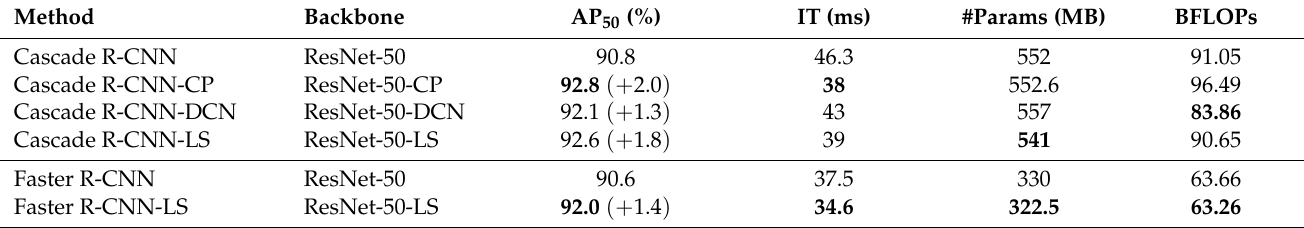
Table 1. Experiment results on SSDD with Cascade R-CNN and Faster R-CNN as baselines. The postfixes of “CP”, “DCN”, and “LS” in the Method column indicate the different sparse density feature extraction modules in the network, which are pooling after extraction, deformable convolution, and the proposed lifting scheme layer, respectively. The evaluation metrics include detection performance metrics of average precision at IOU threshold = 0.5 (AP 50 ) and network efficiency metrics of inference time (IT), the number of parameters (#params), and billion float operations (BFLOPs). The values in the parentheses in the AP 50 column represent the increment compared with the baselines. The best results are in bold.